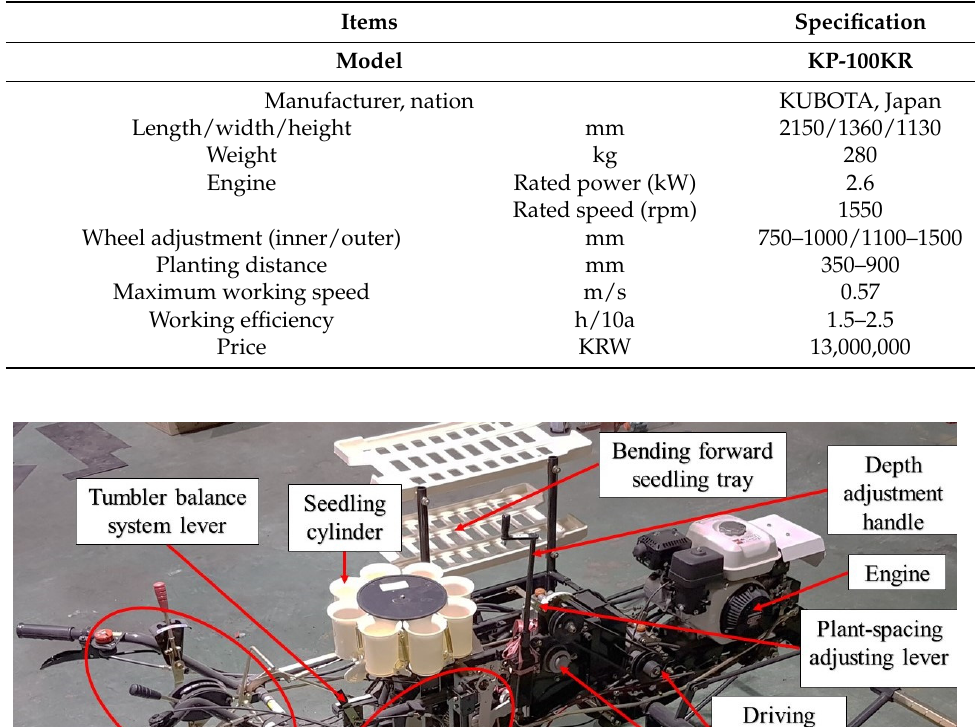
Figure 1. View of cam semi-automatic vegetable transplanter. Table 1. Main specifications of the cam semi-automatic vegetable transplanter.